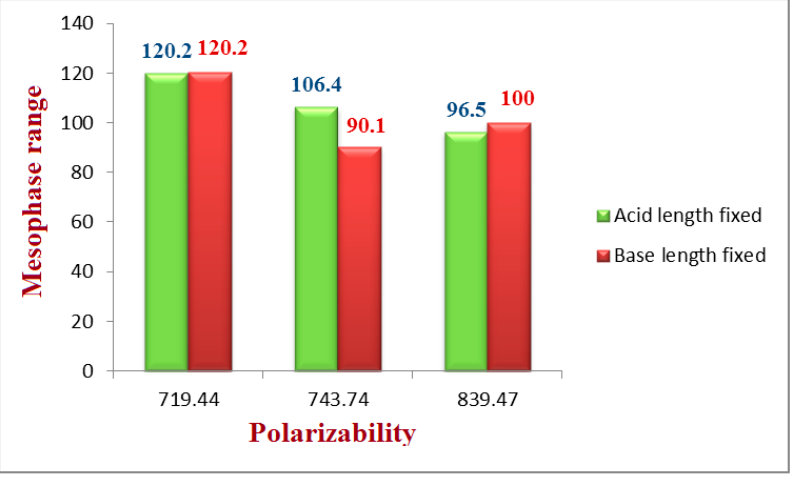
Figure 7. The relationship between the polarizability of the SMHBCs ( An / Bm ) and the total mesophase range.